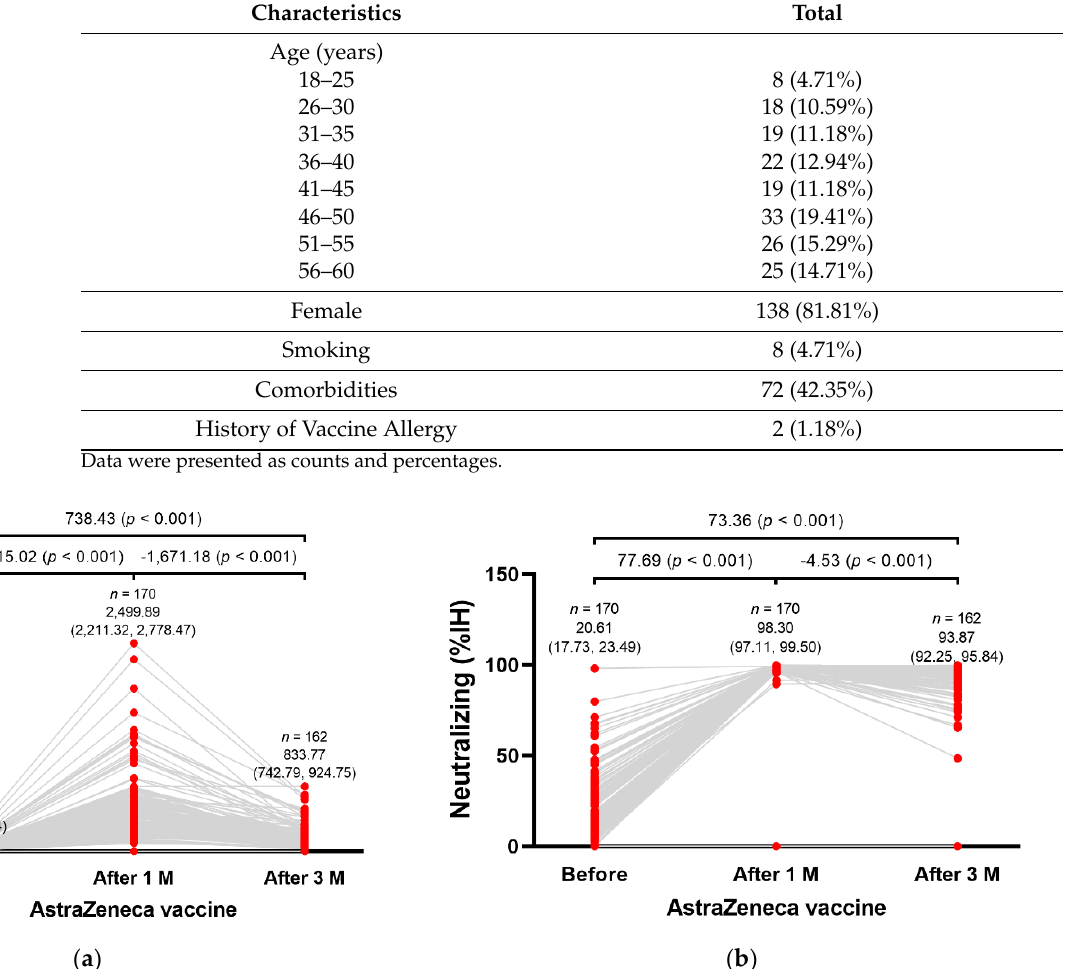
Table 1. Characteristics of Participants ( n = 170).